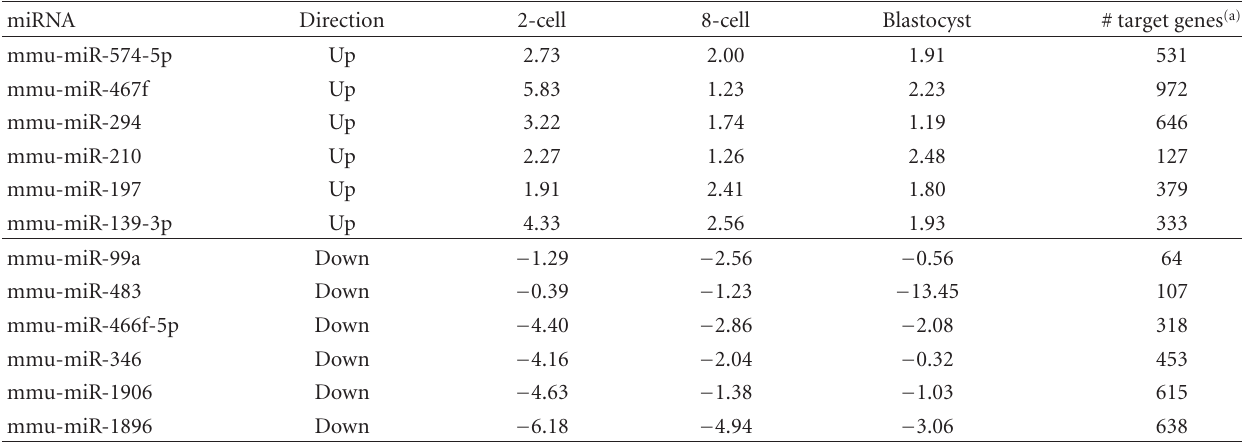
Table 1: Expression levels of the six up- and down-regulated miRNAs in developing embryos derived from B[a]P exposed fathers, relative to unexposed controls.